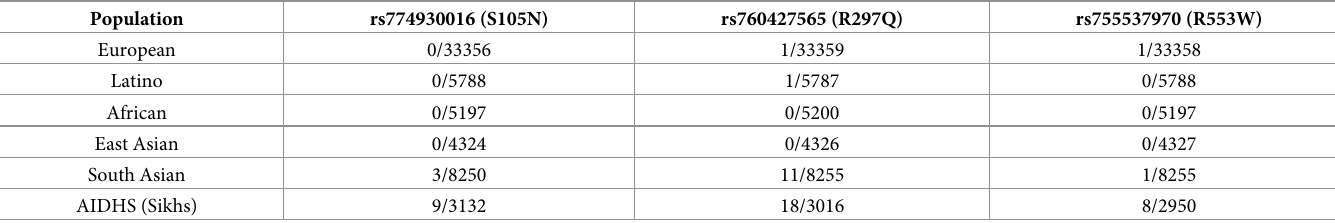
Table 2. Carrier counts for three population-specific variants in the GCKR gene in AIDHS and multiethnic populations.